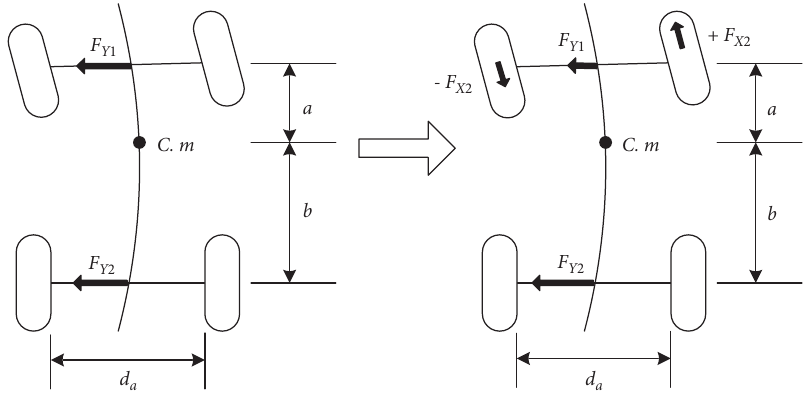
Figure 3: Force situation of the vehicle’s steady-state circular